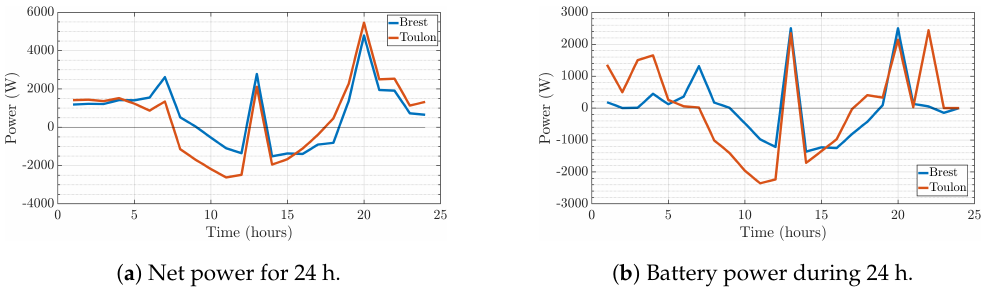
( a ) Net power for 24 h. Figure 10. Case study 2: Net power representing the difference between renewables energy generation and load consumption and batteries power for Brest and